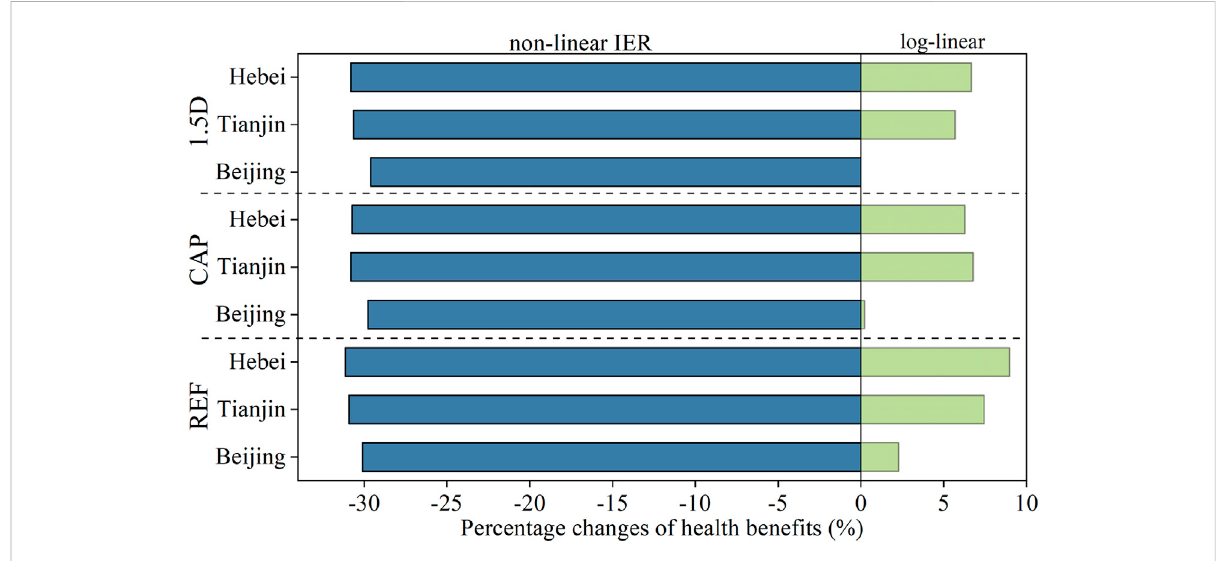
FIGURE 8 Sensitivity analysis results of health bene fi ts in Beijing, Tianjin, Hebei in